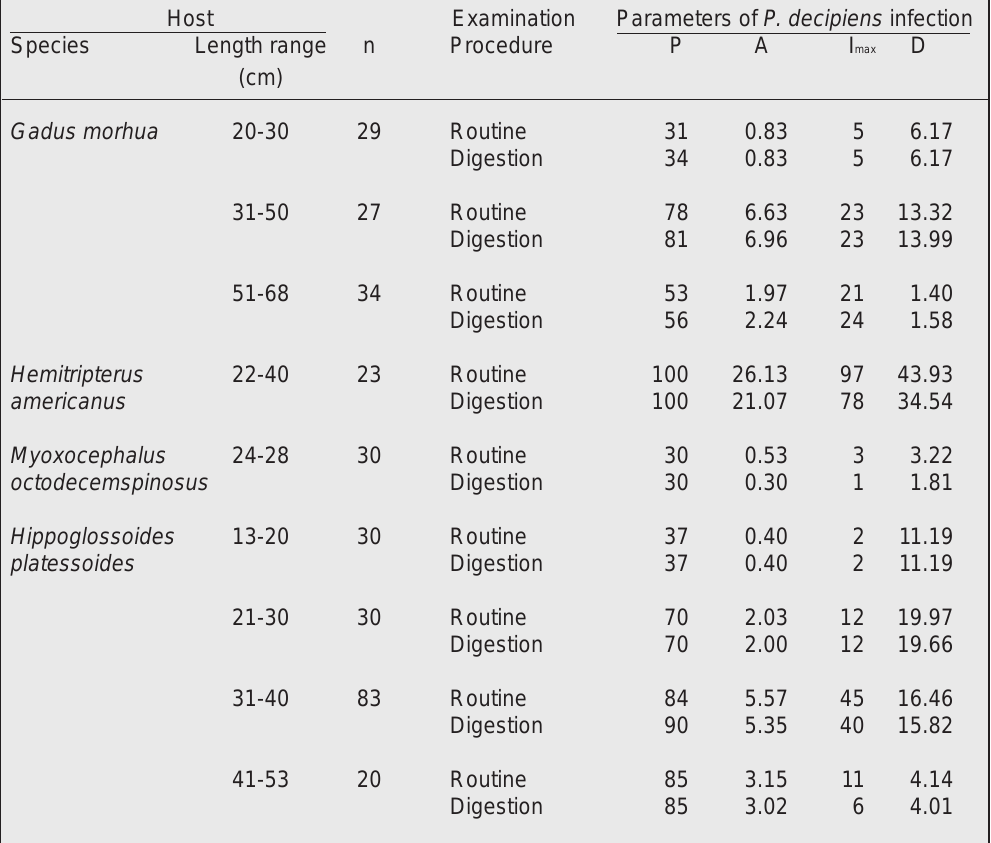
Table 4 . Prevalence (P), abundance (A), maximum intensity (I max ) and density (D) (no. kg-1 host round weight) of Pseudoterranova decipiens larvae found in frozen samples of Scotian Shelf and Gulf of Maine groundfish by routine examination employing slicing and candling of host flesh, and following digestion